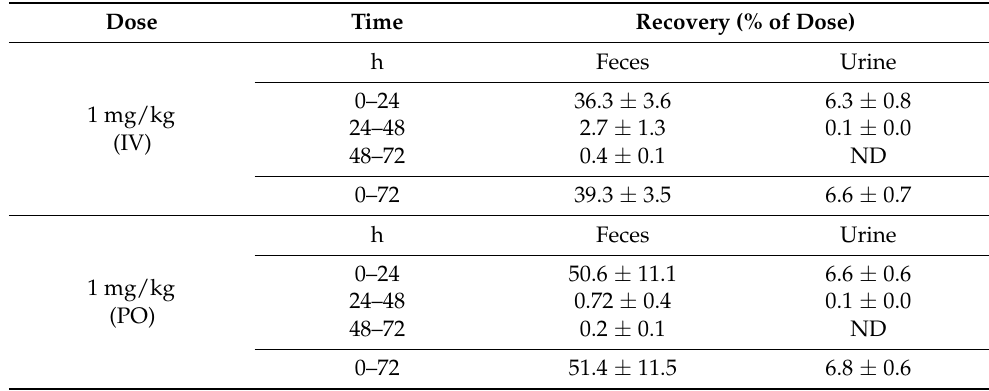
Table 4. Recovery of enavogliflozin for 72 h in mice.